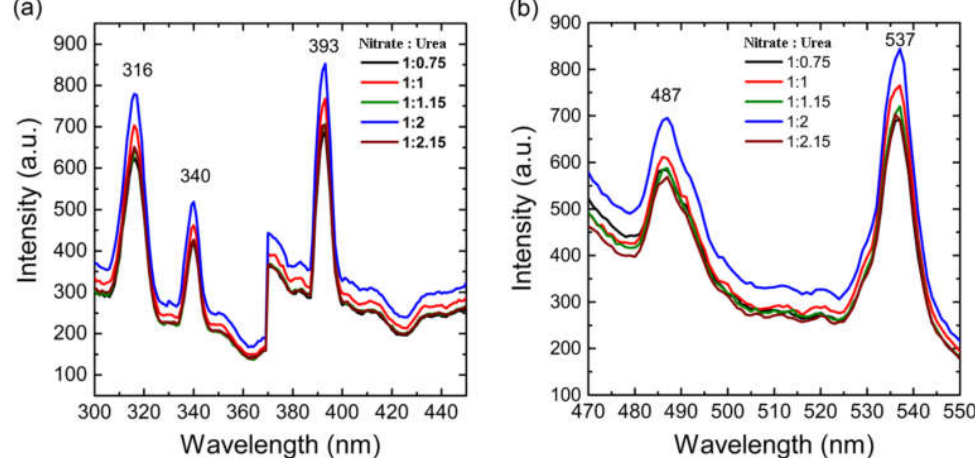
Figure 5. Photoluminescence properties of ( a ) excitation and ( b ) emission of τ-phase Ba 1.3 Ca 0.7 SiO 4 powder samples.